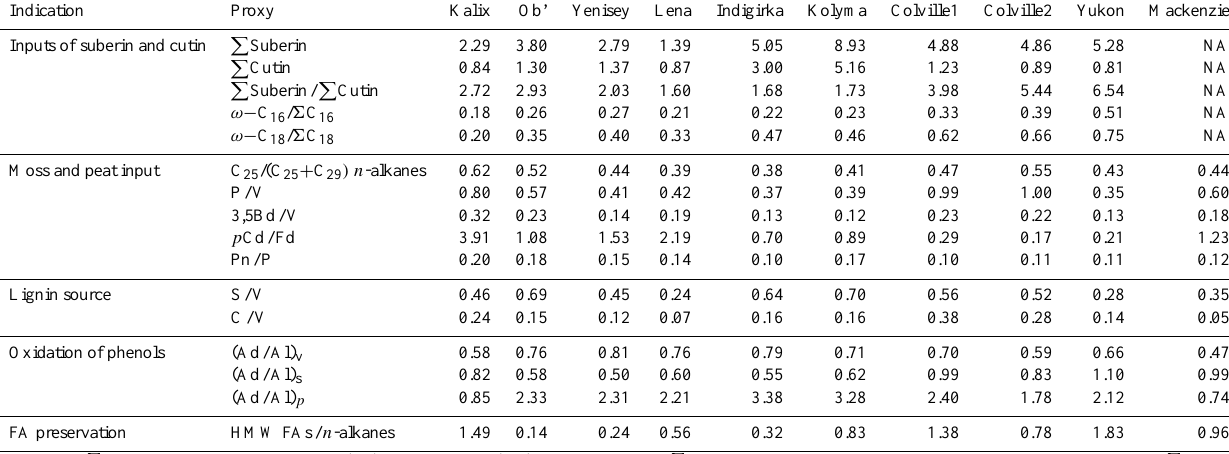
Table 3. Biomarker-based parameters of organic matter (OM) sources and degradation stages used in this paper. Indication